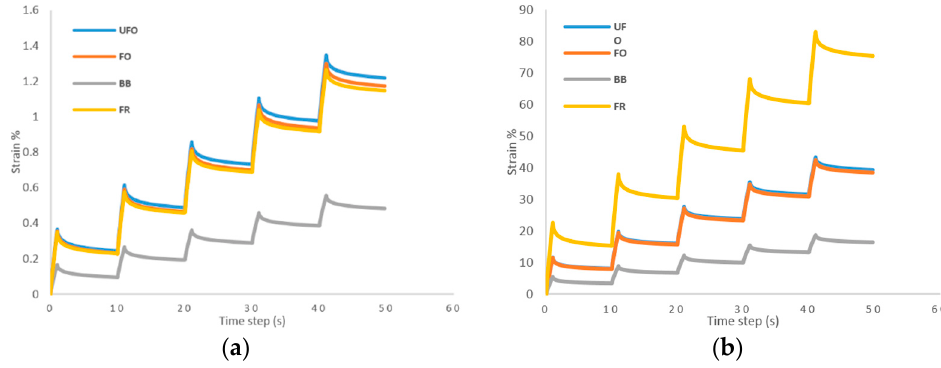
Figure 10. Five cycles of Creep and Recovery at 34°C ( a ) with 0.1 kPa stress ( b ) with 3.2 kPa stress.